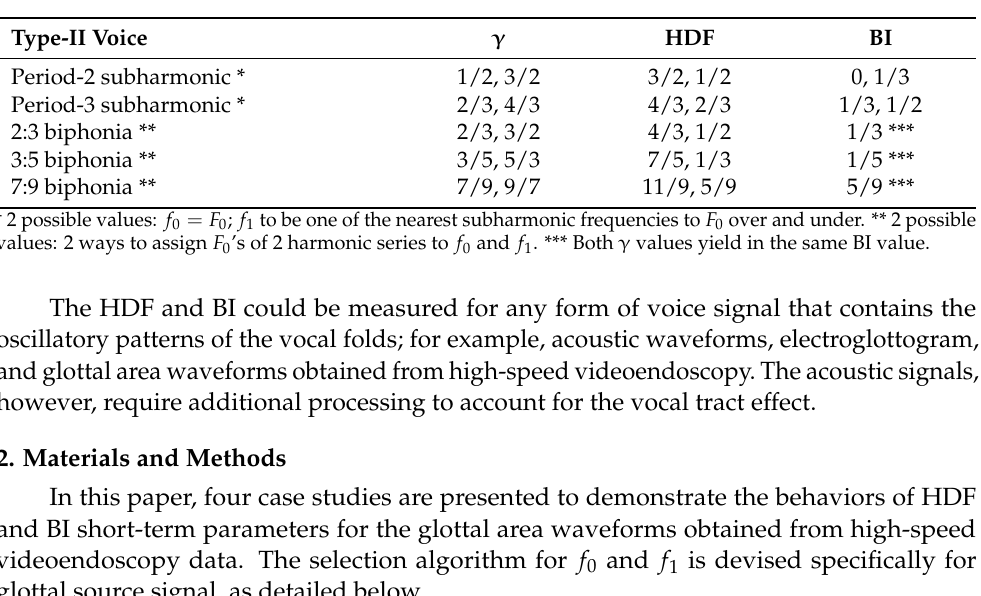
Table 2. Expected HDF and BI values for different Type-II